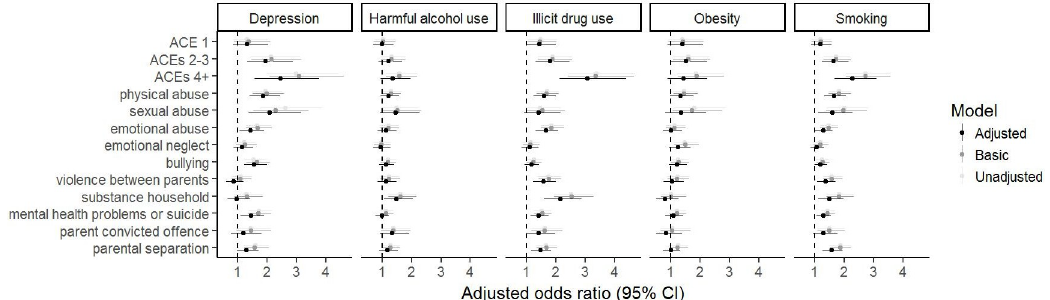
Fig 2. Forest plots for the associations of the ACE score and separate ACEs with poor health outcomes. The reference category for each category of the ACE score (1, 2–3, and 4+) is experiencing 0 ACEs. The basic model is adjusted for sex. The adjusted model additionally includes home ownership, maternal and partner education, household social class, parity, ethnicity, maternal age, maternal marital status, and maternal and partner depression during pregnancy. ACE, adverse childhood experience; CI, confidence